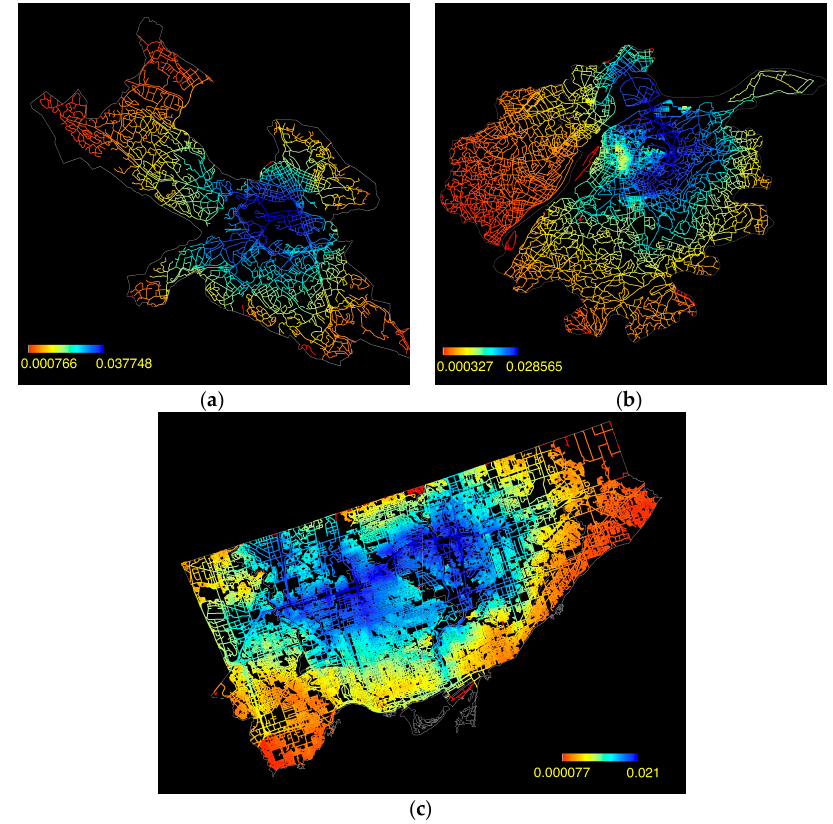
Figure 6. Closeness distributions of the urban street systems of ( a ) Stockholm; ( b ) Nanjing, and ( c ) Toronto (the values of closeness centrality are divided into 32 classes from the minimum to the maximum, corresponding to the color from red to blue).